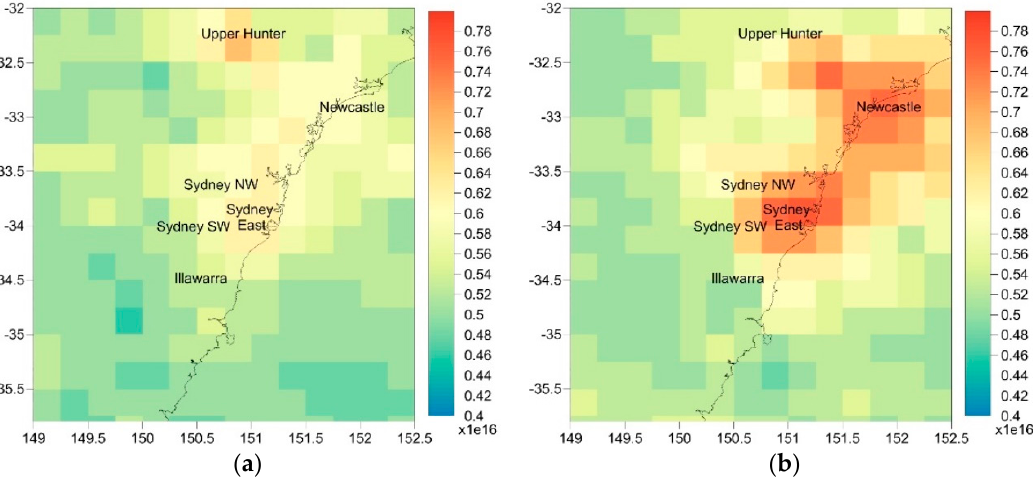
Figure 15. Time averaged map of NO 2 tropospheric column (30% cloud screened) daily 0.25° (OMI OMNO2d v003) 1/cm 2 over the periods of: ( a ) SPS1; and ( b ) SPS2. Analysed by NASA Giovanni platform [40].